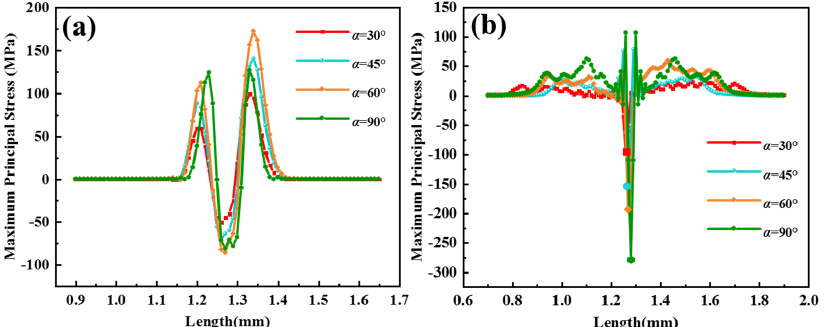
Figure 12. Maximum principal stress curve of path 1 in different contact forms: ( a ) surface contact, ( b ) line contact.